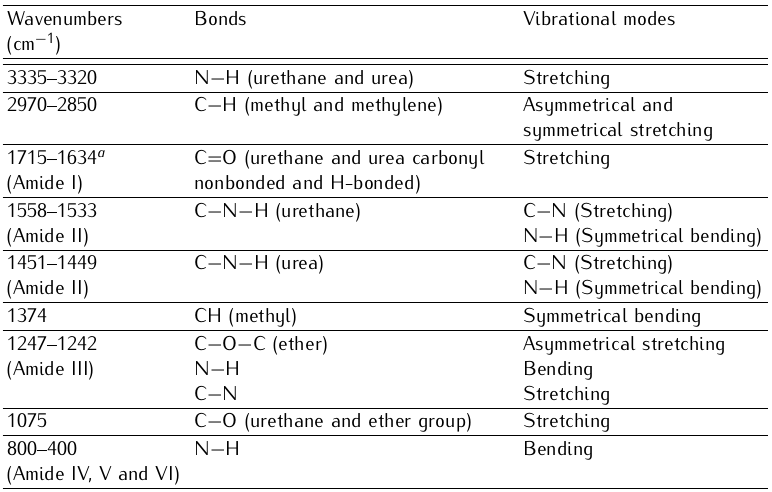
Table 2. Characteristic group absorptions present in FTIR spectra of the polyurethanes and poly(urethane-urea)s films cast from aqueous dispersion [1, 2, 5–8, 19–22, 24, 25,